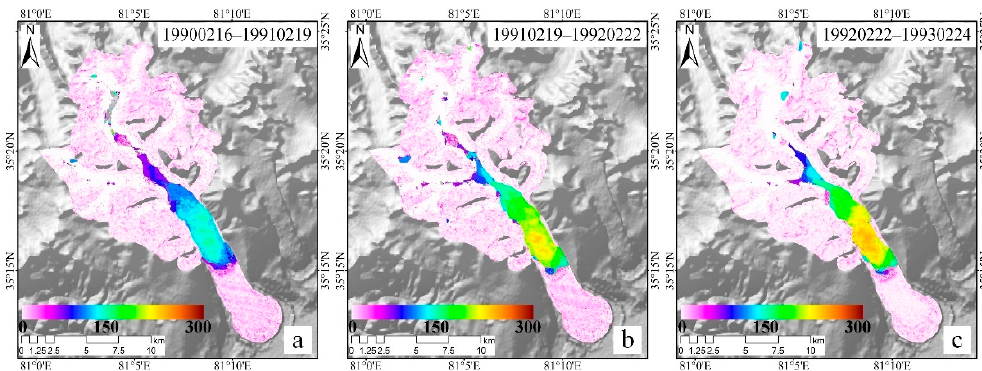
Figure 3. Flow velocities (m yr − 1 ) of the Chongce Glacier during the periods of 16 February 1990–19 February 1991 ( a ),